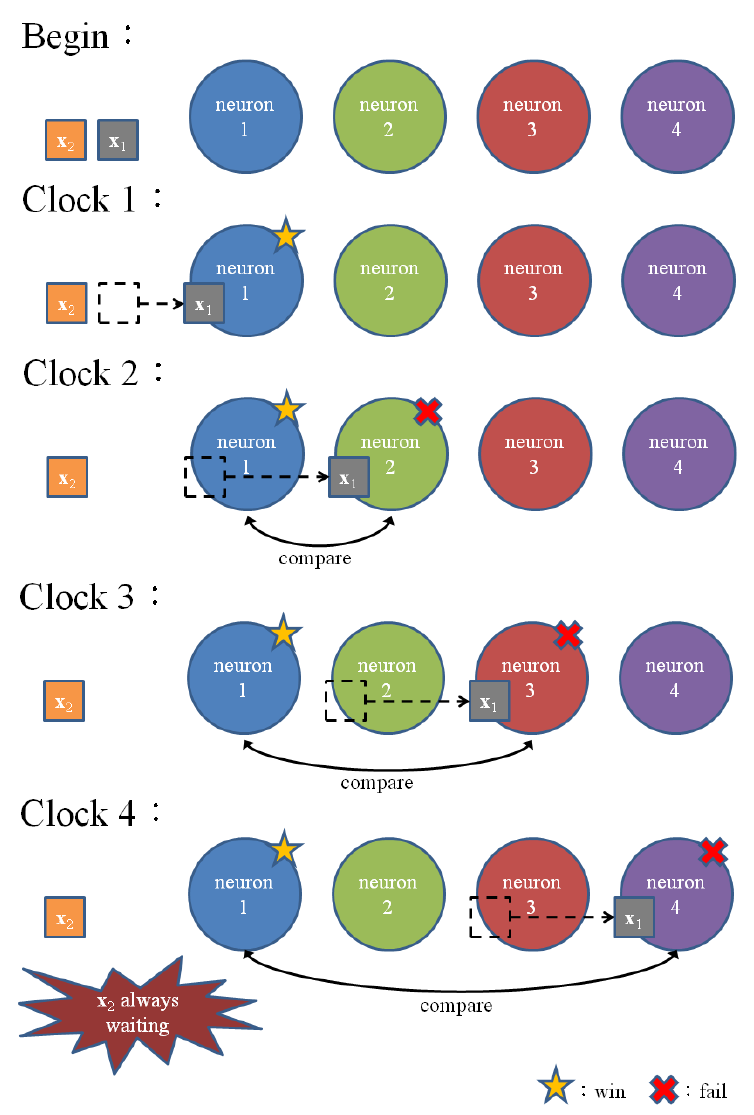
Figure 3. An example of pipeline without codeword swapping